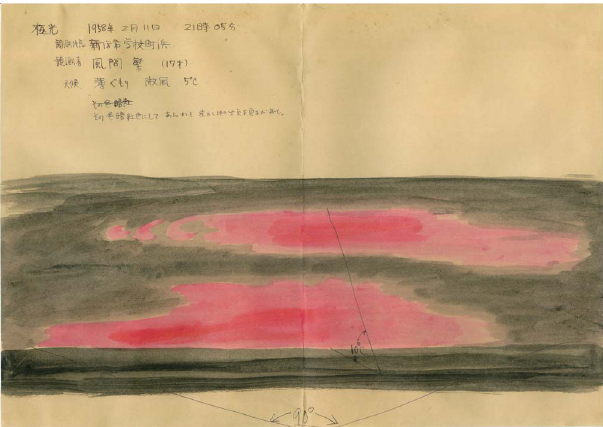
Fig. 1. The auroral painting on 11 February 1958. The information written in Japanese can be translated in English as follows: Northern light; 2105 JST on February 11, 1958. Observation site; Gakko-cho Hama, Niigata City. Observer; Shigeru Kazama (17 years old). Weather; slightly cloudy, weak wind, 5 (cid:1) C. Others; the color was dark-red, looked like a fi re of cities far away.